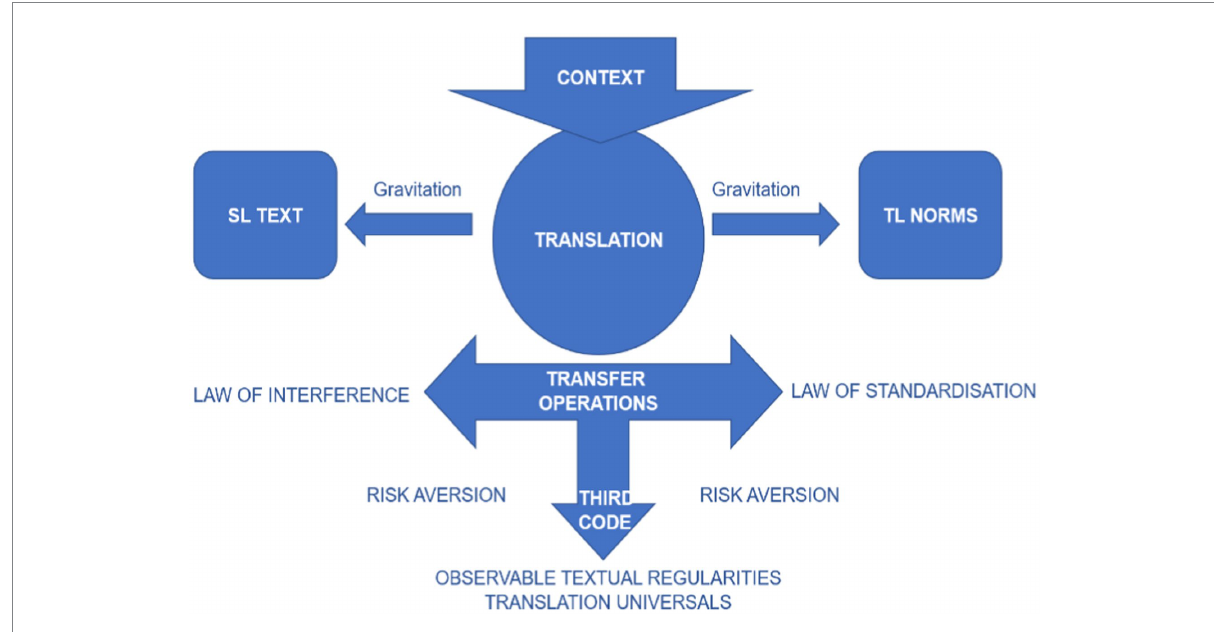
FIGURE 2 The model of translation universals’ inception. Figure reproduced from Robin (2017), with permission from John Benjamins Publishing.